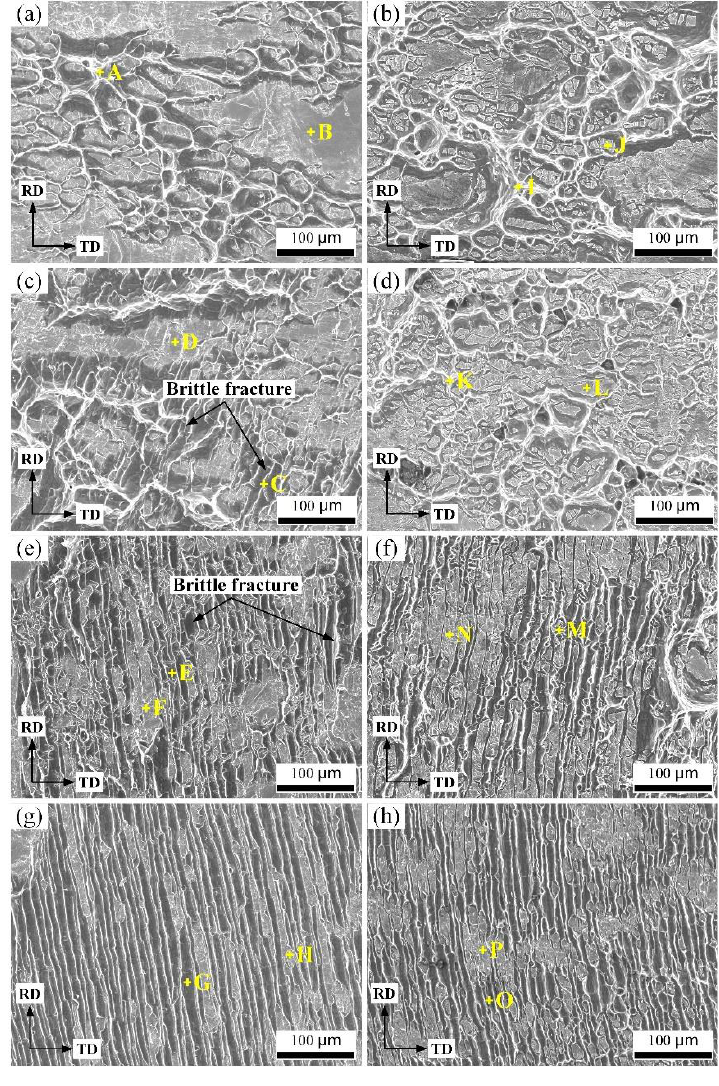
Figure 10. SEM images of peeling section at trough: ( a , b ) 10 min, ( c , d ) 20 min, ( e , f ) 40 min, ( g , h ) 60 min; ( a , c , e , g ) Cu side, ( b , d , f , h ) Al side. Table 5. The element contents of Cu and Al by point scanning of peeled section at peak (wt%).